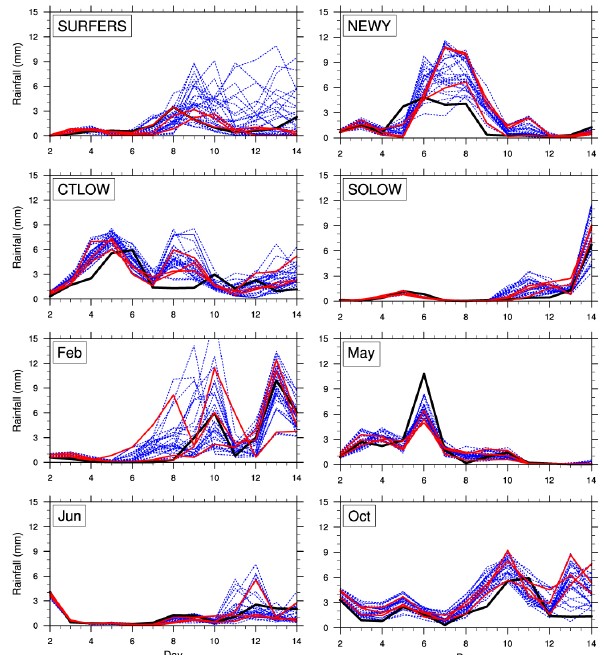
Fig. 3. Daily precipitation time series for each of the eight test pe- riods. Observations are show in black. All ensemble members re- tained after the performance evaluation are shown with blue dotted lines. The three members chosen using the independence measure are shown in